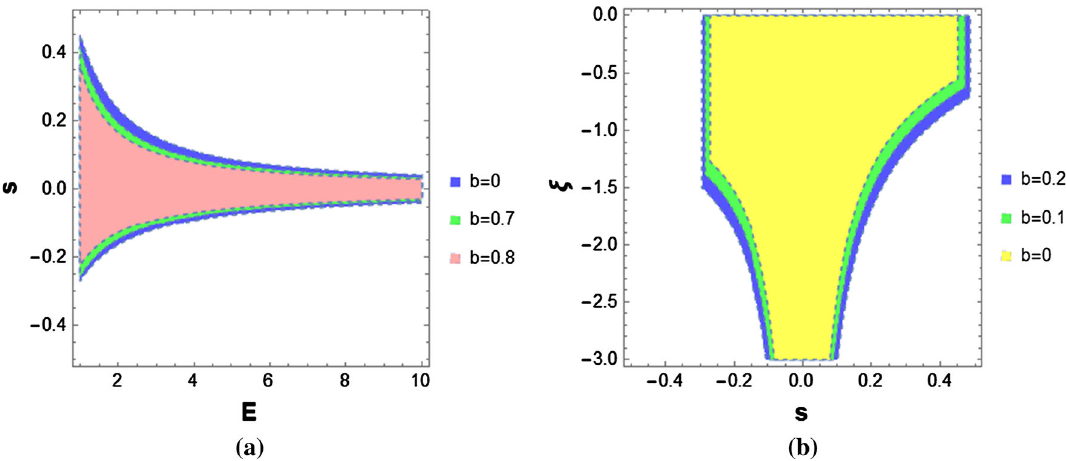
Fig. 1 a The condition of the spin s and the energy E that the particles can reach the event horizon for different value of b . b The condition of the spin s and the ξ that the particles can fall into the horizon for different value of